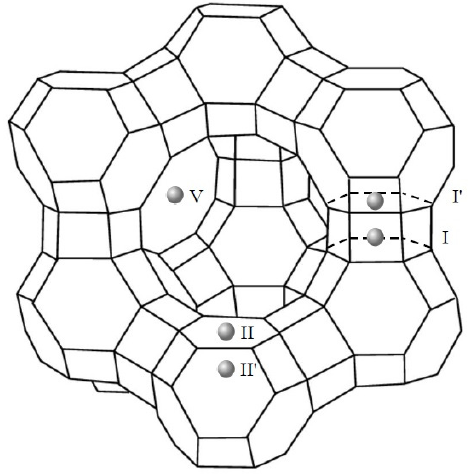
Figure 5. Possible cation locations at the faujasite structure of zeolite Y according to [48,58].